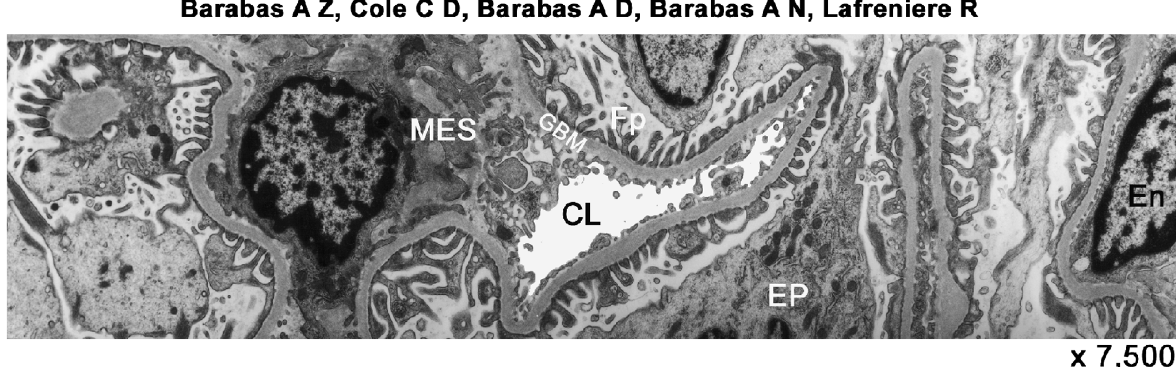
Figure 4. Glomerular capillary loops of an SPHN pre-/post-treated rat showing evenly thin GBMs, preserved foot processes, and no change in the epithelial cells ( £ 7500). CL, capillary-loop; D, deposit; En, endothelial cell; Ep, epithelial cell; Fp, foot process; GBM, glomerular basement membrane; MES, mesangial cell.